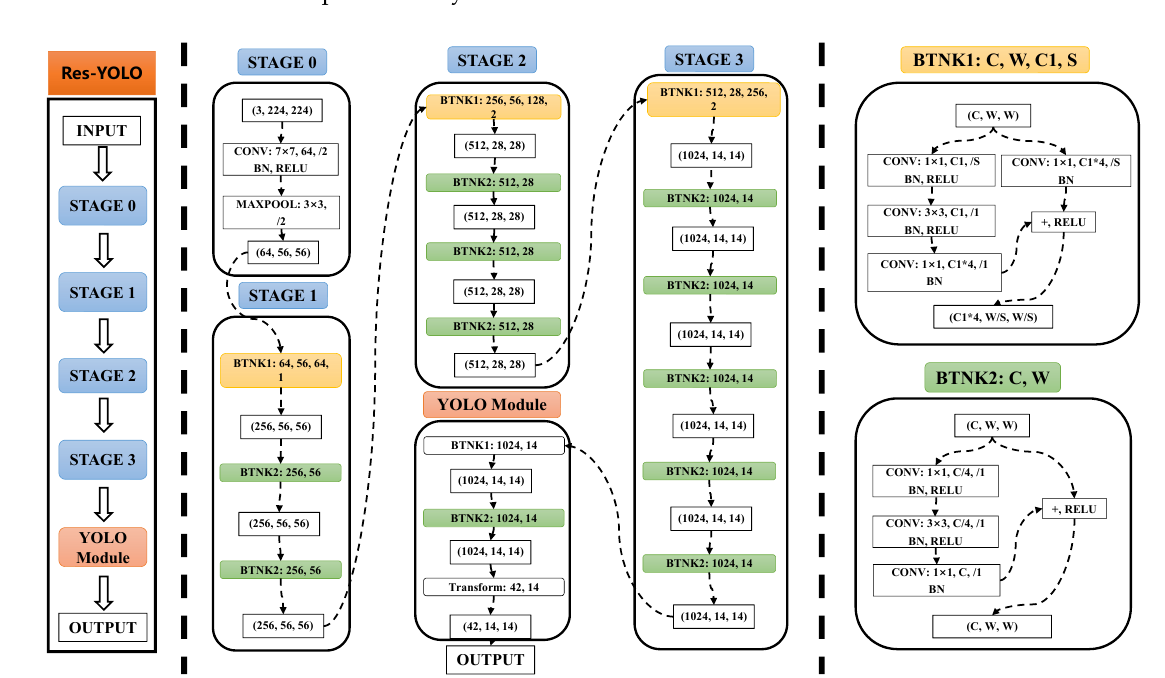
(5) Stage 4 layer: BTNK1 process for 1 time and BTNK2 process for 2 times, and finally processed by YOLO module.